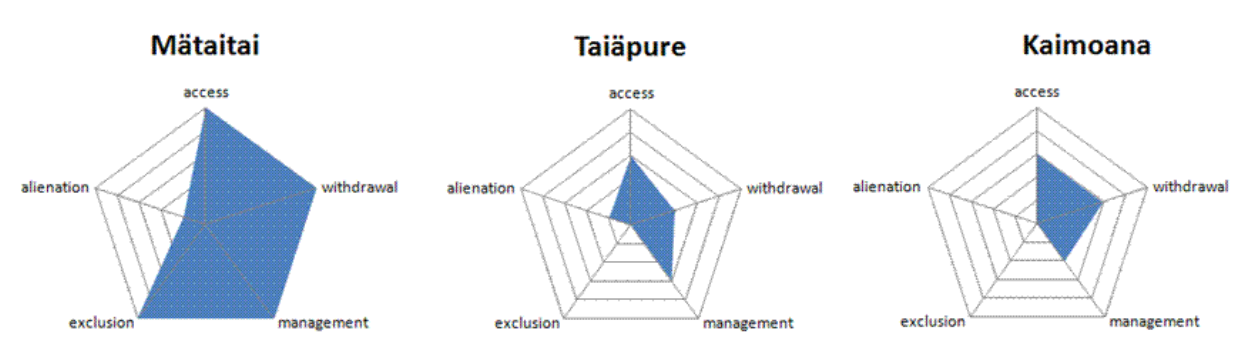
Fig. 4. Comparison of property rights bundles for customary Maori fishing: mätaitai, taiäpure, and